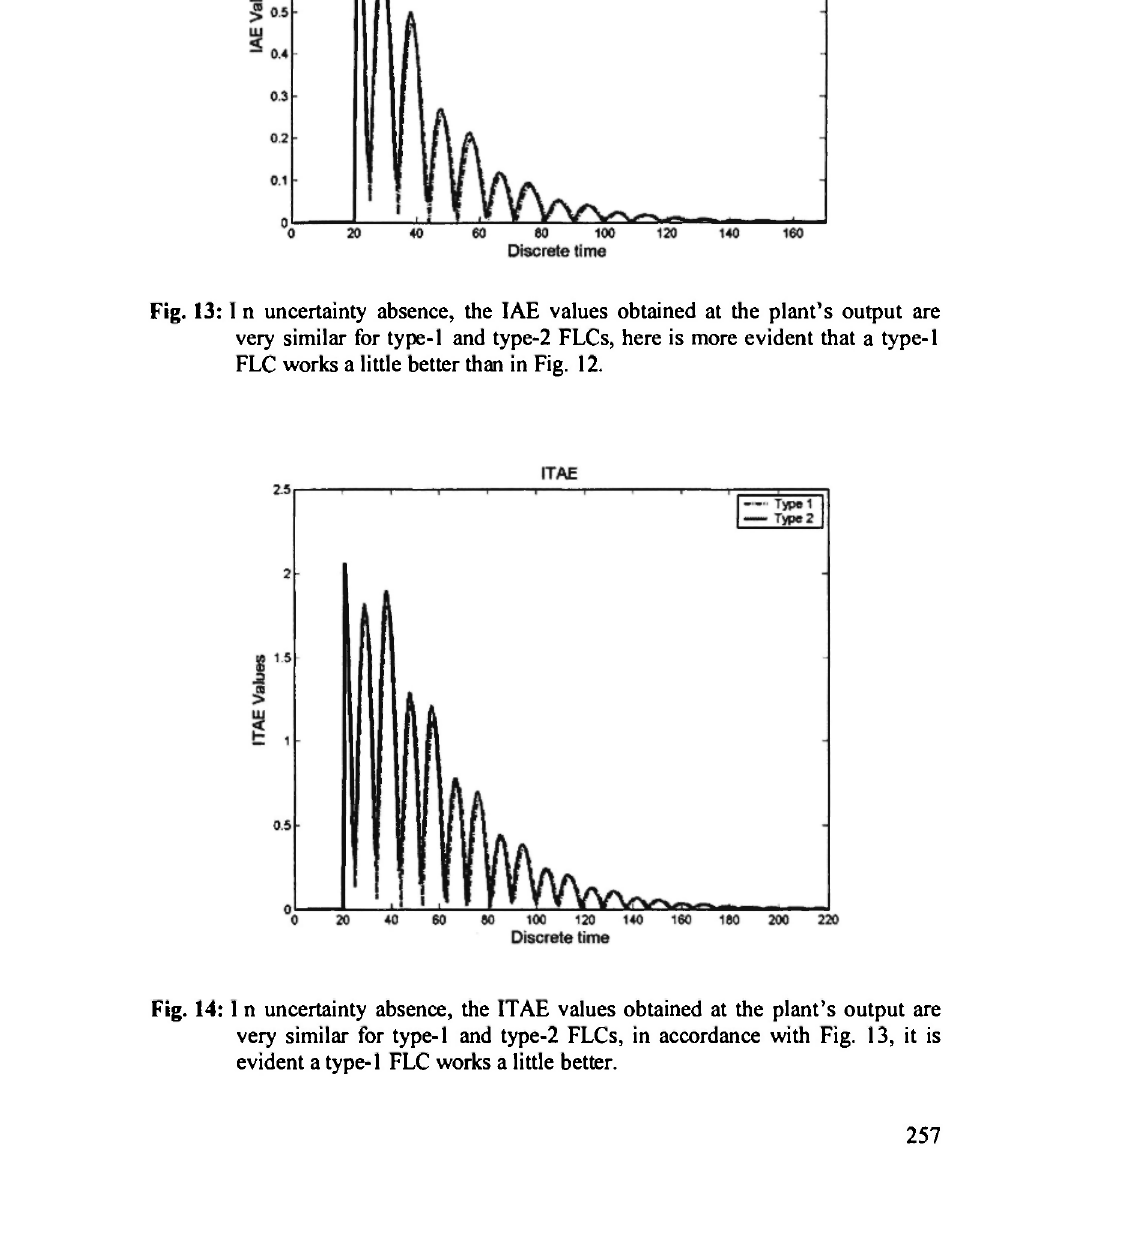
Fig. 14: 1 η uncertainty absence, the ITAE values obtained at the plant's output are very similar for type-1 and type-2 FLCs, in accordance with Fig. 13, it is evident a type-1 FLC works a little